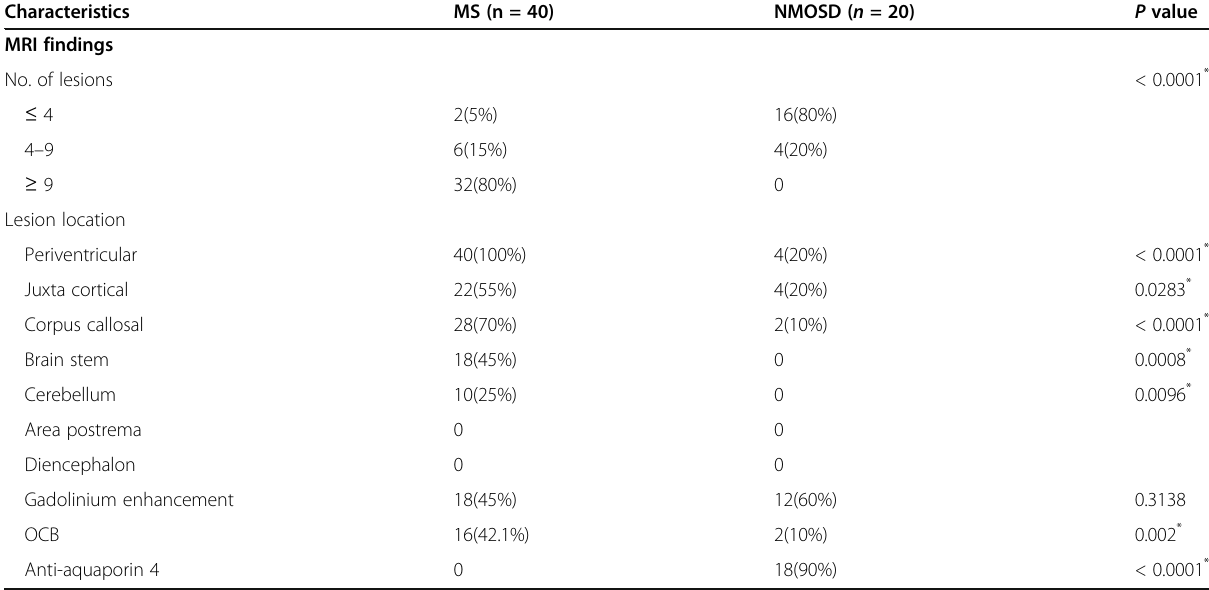
Table 2 MRI characteristics of NMOSD and MS patients